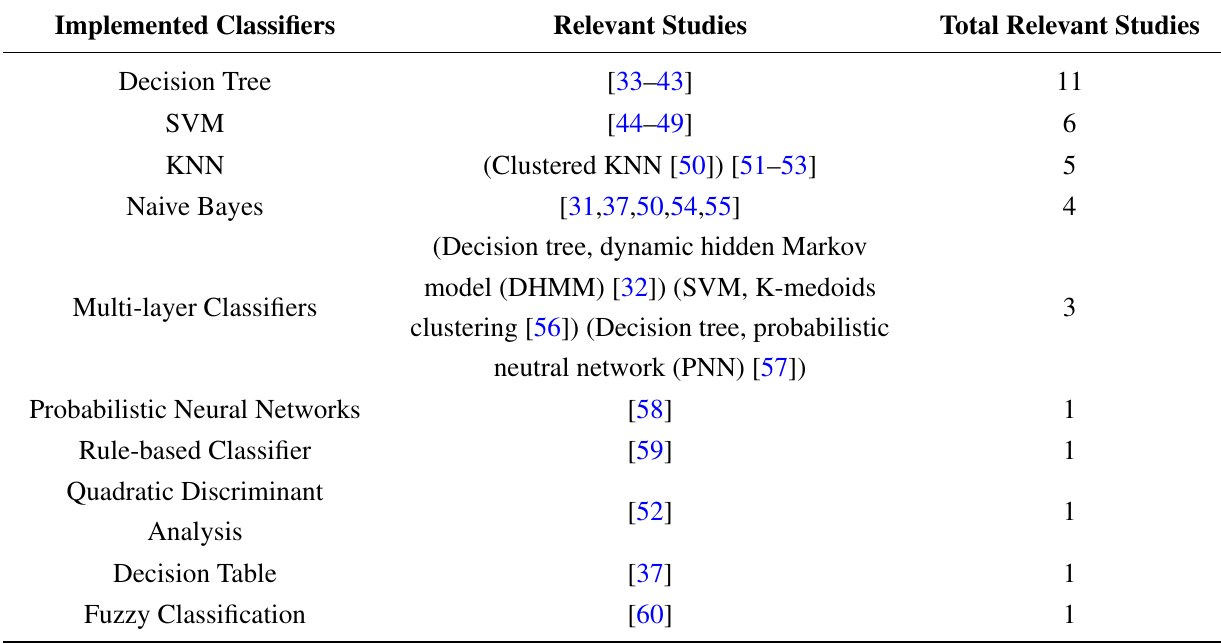
Table 1. Implemented classifiers on mobile phones for online activity recognition.